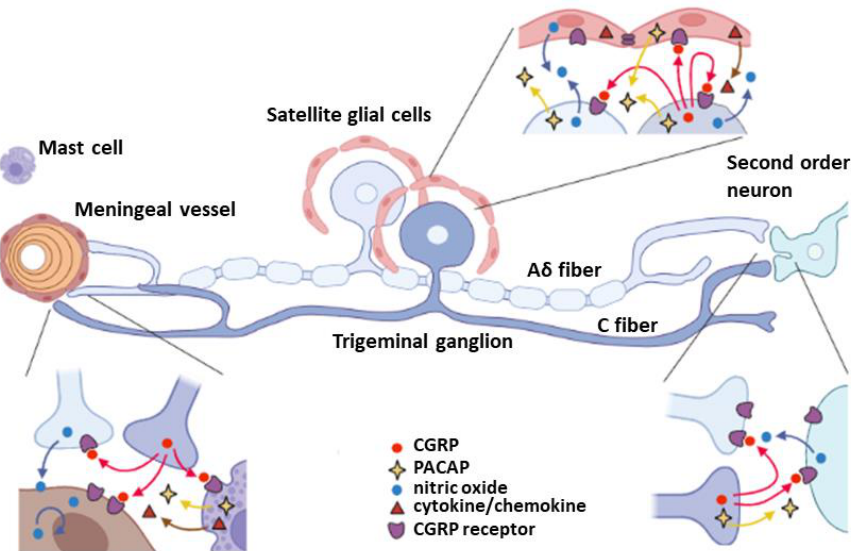
Figure 1. Schematic signal transduction pathways of TG neurons. There are mainly three modulatory regions that are important in nociceptive regulation of TG neurons; peripheral end terminal on the meningeal blood vessels, TG regions associating with satellite glial cells, and central terminal connecting to the second order neurons in TNC. Aδ fiber and C fiber neurons have distinct gene regulations, for instance CGRP and its receptors expression. CGRP plays a critical role in vasodilation as well as TG neuronal activity through induction of NO and cytokine/chemokine production, that can in turn trigger more CGRP release and nociception.